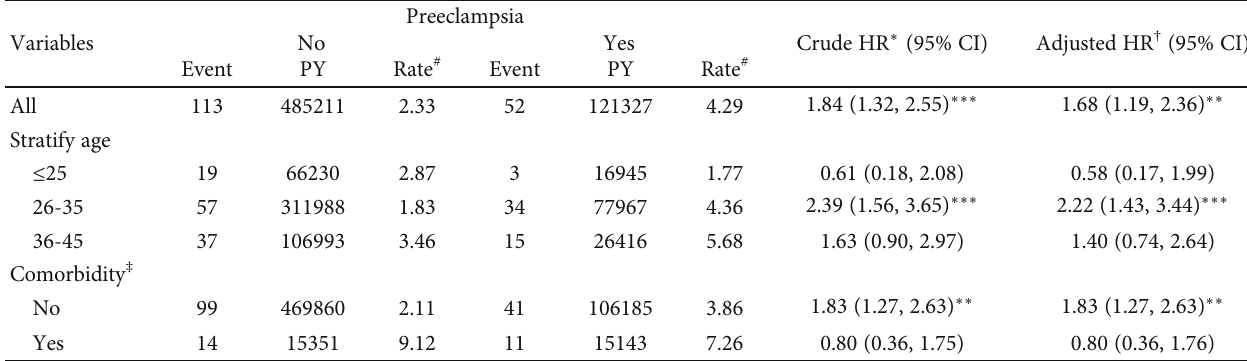
Table 2: Incidence densities of the pancreatitis hazard ratio in women with and without preeclampsia strati fi ed by age and presence of comorbidity.